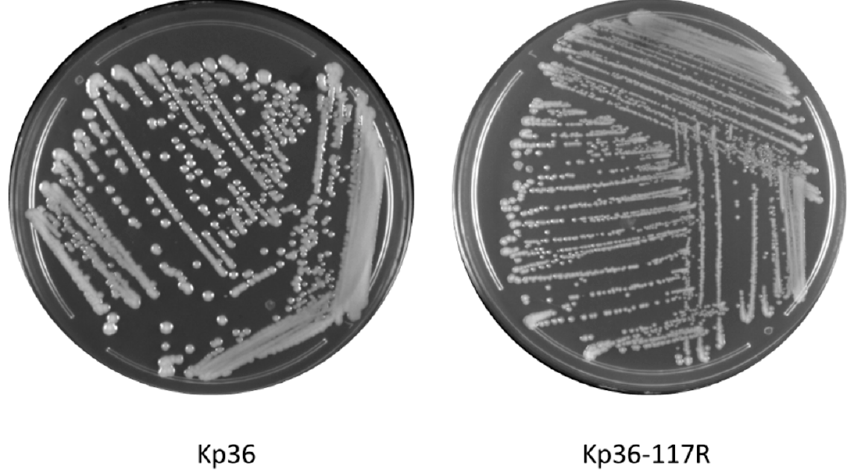
Figure 1. Morphology comparison between colonies of K. pneumoniae on parental strain Kp36 (mucoid, moist, and sticky) and phage 117-resistant mutant Kp36-117R (dry, rough, and transparent) on 1.5% LB agar.